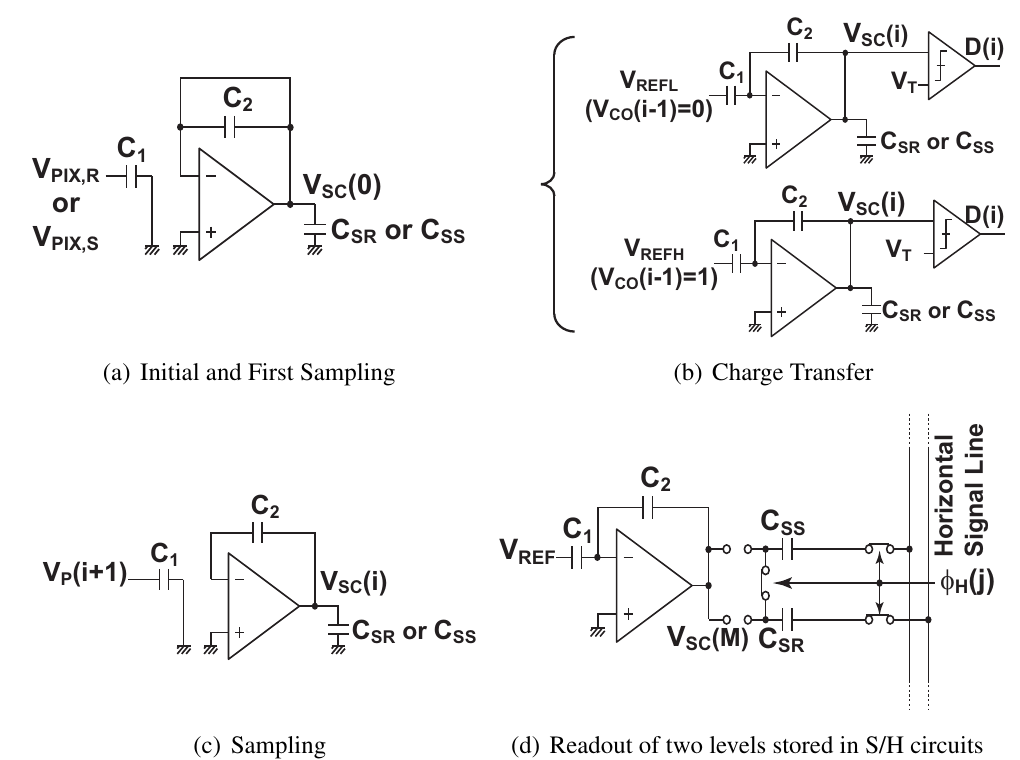
Figure 4. Phase Diagram of Correlated Multiple Sampling Circuits using Folding Integration